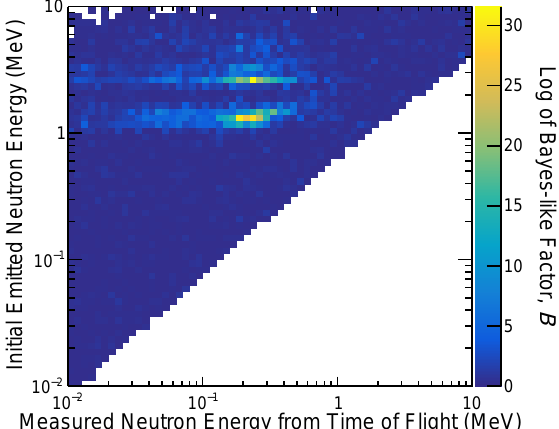
Figure 3: The matrix of the log of Bayes factors for in- creasing the 27 Al( n , n ) cross section by